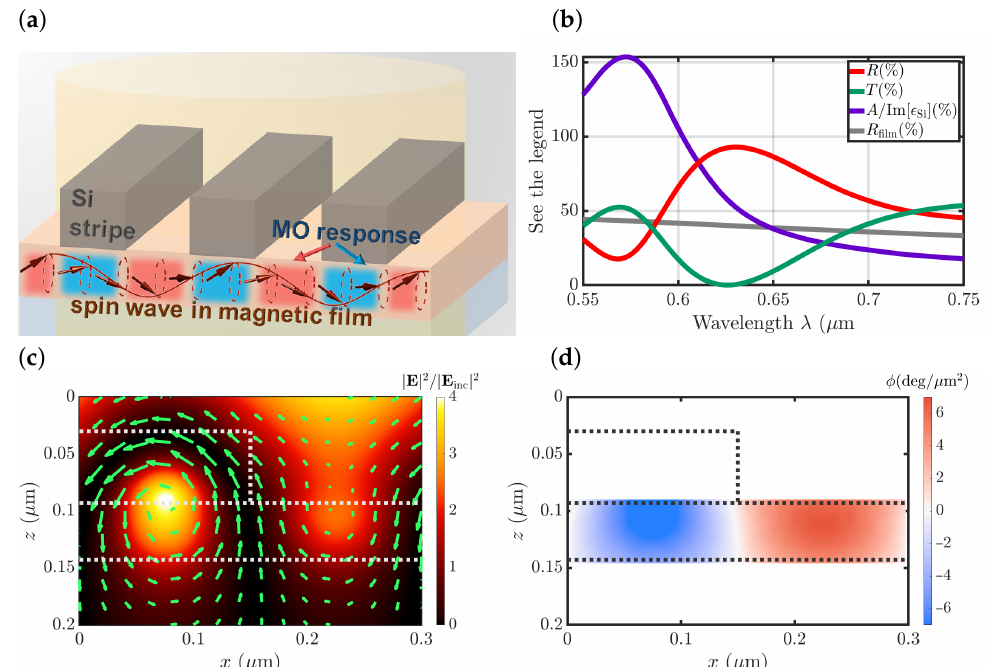
Figure 2. Optical properties of all-dielectric metasurface under the illumination of s-polarized light. ( a ) Scheme of the Mie-based structure and a magneto-optical short spin-wave spectroscopy. ( b ) Spectra of reflectance R (red line), transmittance T (blue line) and normalized absorption A /Im [ ε Si ] (violet line) of the metasurface. Reflectance spectra of the same bare film are shown by the grey line R film . ( c ) Electromagnetic field distribution at λ = 620 nm wavelength in the metasurface. | E | 2 is shown by colour, H -vector is shown by green arrows. Si stripe and magnetic film layer are shown by the grey dotted line. ( d ) Distribution of φ ( x , z ) at λ = 620 nm wavelength in the metasurface shown as a false-colour